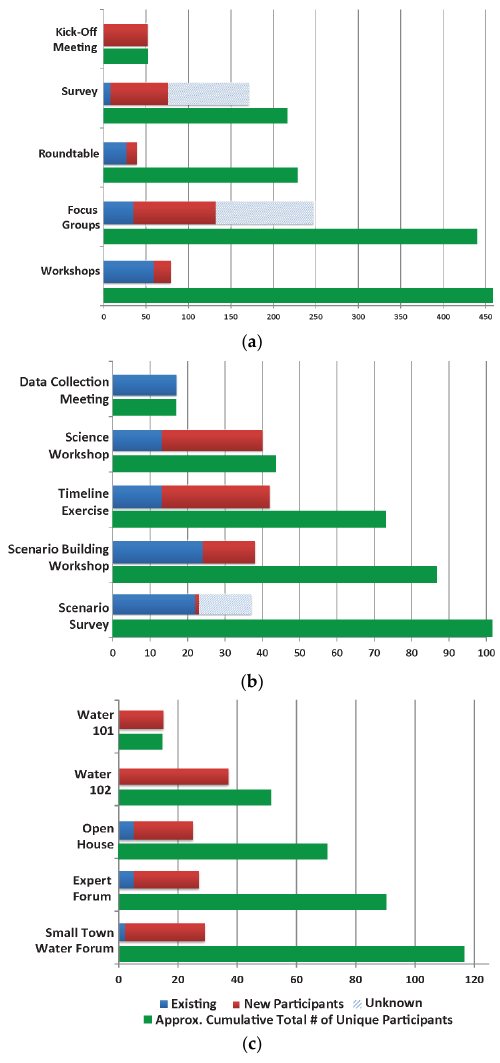
Figure 4. Number of participants in each activity and repeat and increasing engagement. ( a ) Roadmap; ( b ) Gila; ( c ) Clarkdale.